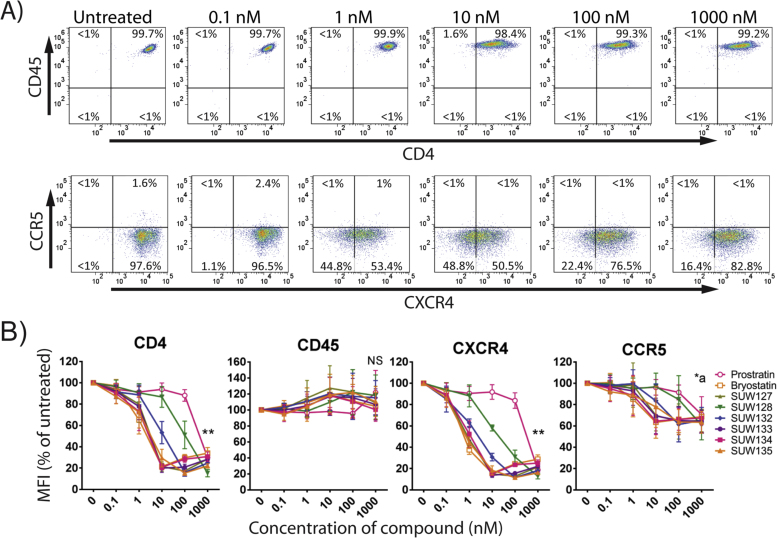
Compound-induced reduction of cell surface molecules in primary CD4 + T cells. A) CD4 + T cells from a healthy human donor were exposed to the indicated concentrations of bryostatin for 24 h before harvesting. Expression levels of cell surface CD45, CD4, CCR5, and CXCR4 were assessed by flow cytometry. Representative flow cytometry plots are shown. B) Cells were treated as described in part A with the indicated compounds. The mean fluorescent intensity (MFI) is provided as a percentage of that obtained for untreated cells from the same donor. ** all compounds induced significant reductions (p < 0.001) in receptor levels (untreated vs 1000 nM). NS no compound induced significant reductions in receptor levels (untreated vs 1000 nM). *a p < 0.05 (untreated vs. 1000 nM) for all compounds except prostratin, SUW128, and SUW132 using a 2-sided t-test. Error bars = SEM, N = 3 different primary cell donors.